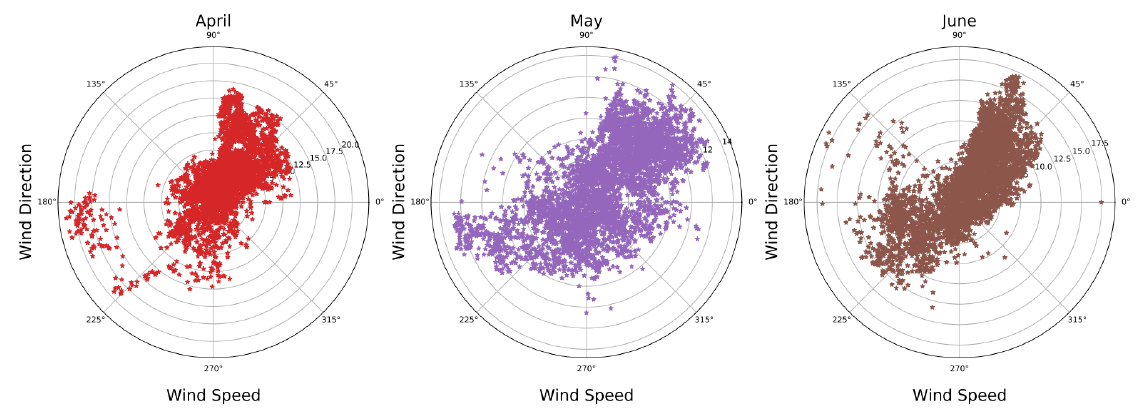
Figure 7. The wind speed and direction for the month of April, May, and June.